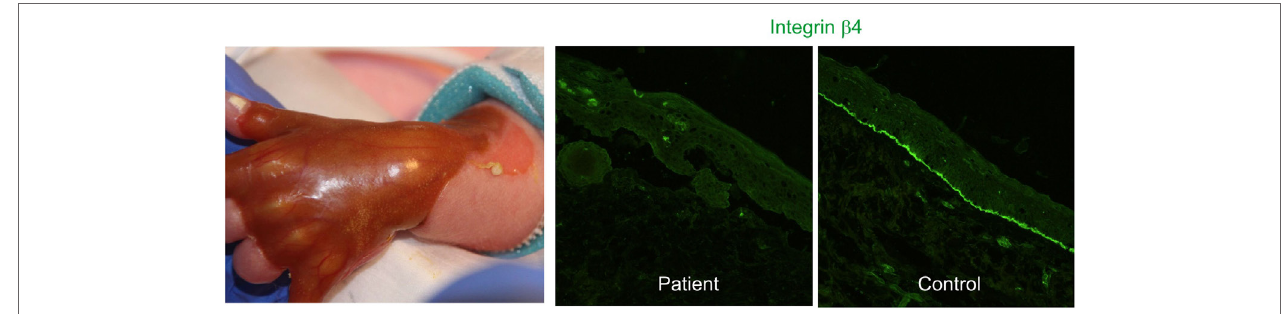
FiGURe 1 | Congenital absence of the skin, also known as aplasia cutis congenita, in a newborn with hydronephrosis and pyloric atresia due to integrin α 6 β 4 deficiency (right panel) [clinical pictures, courtesy of Dr. P. Häusermann (Department of Dermatology